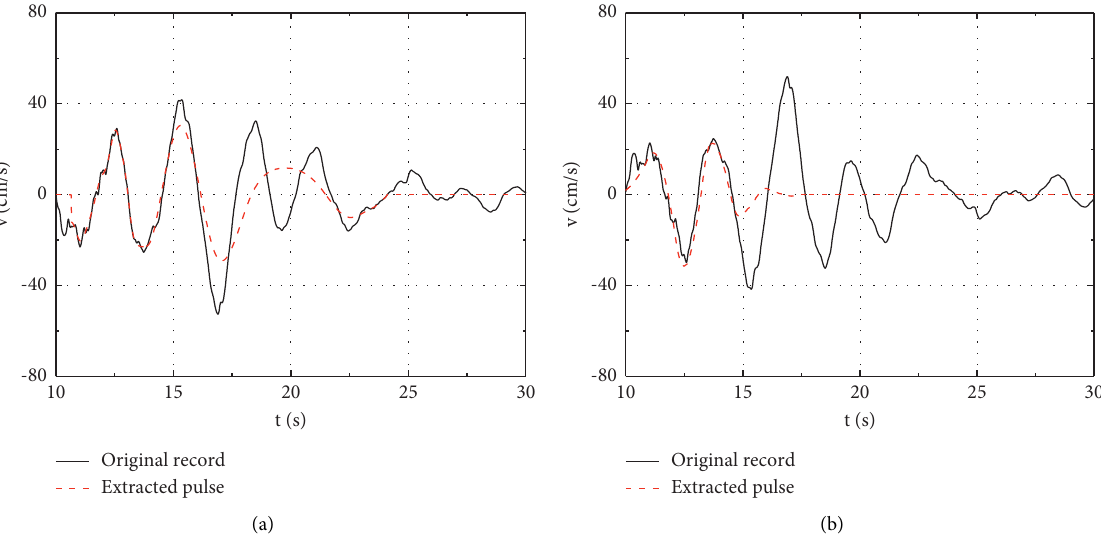
Figure 17: No. 806 ground motion. (a) The extracted pulse based on HHT. (b) The extracted pulse based on wavelet.